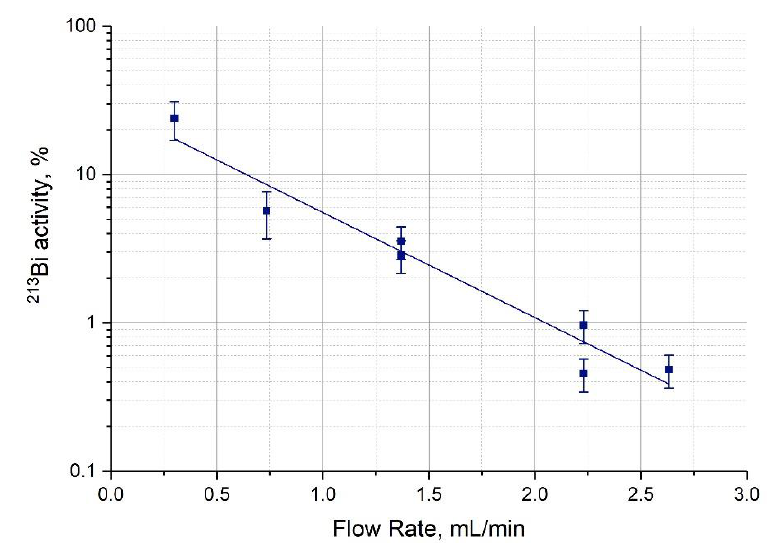
Figure 4. 213 Bi residue on the column containing 0.4 mL Actinide Resin (% to equilibrium activity) depending on the flow rate of mobile phase (0.25 М HNO 3 ) during the accumulation stage.